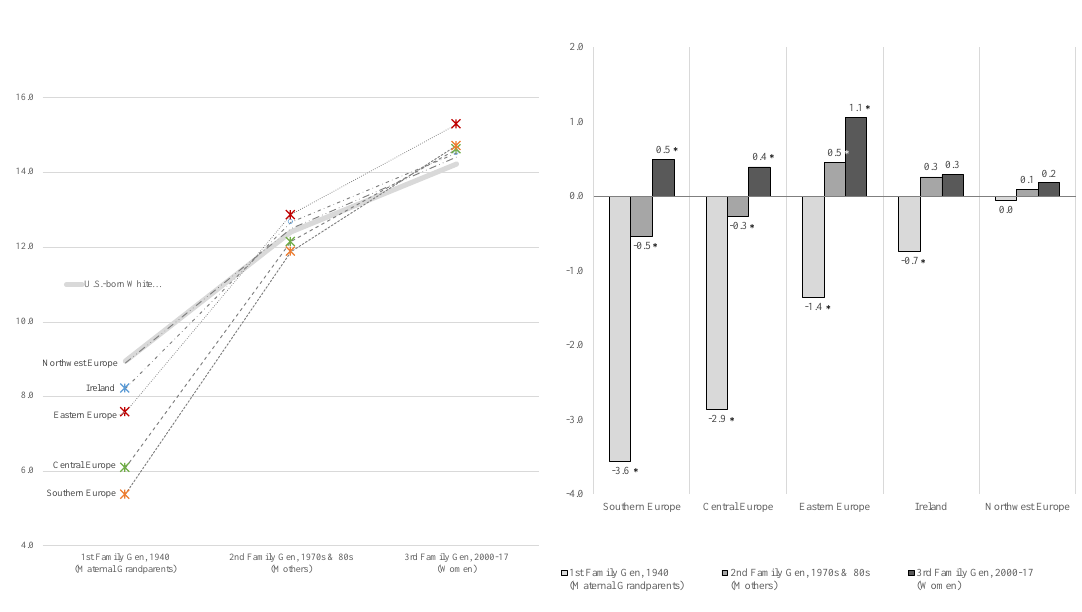
(a) Mean years of education. Figure 2a. Mean Years of Education Figure 2b. Years of Education Relative to U.S.-born Whites Figure 2: Years of education among women by generational status and ethnic origin. *Significant difference between European immigrant origin and U.S.-born white families.